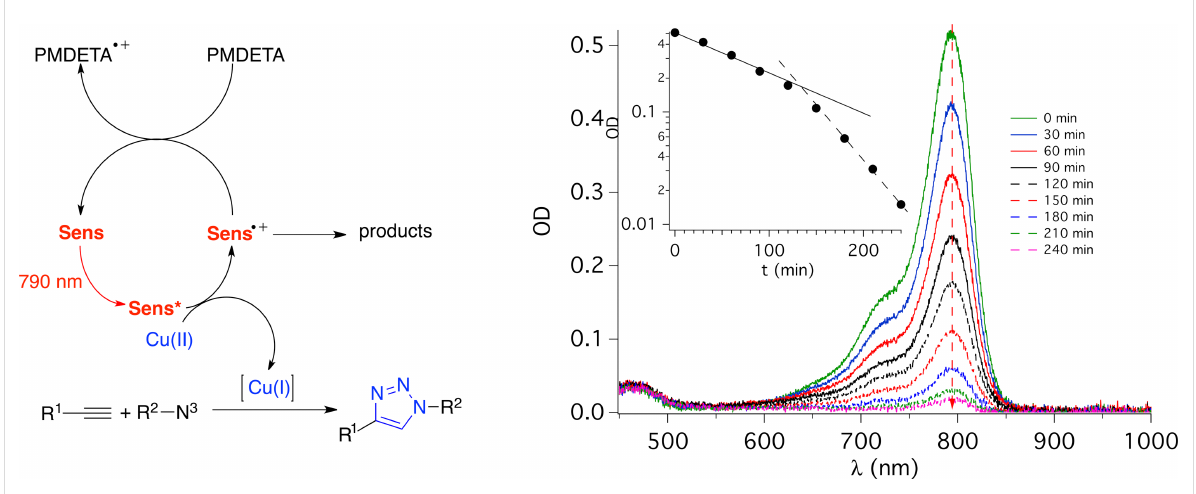
Figure 7: UV–vis–NIR absorption changes of the solution of 48 in the presence of PMDETA, phenylacetylene and benzyl azide in DMSO upon expo- sure at 790 nm (under nitrogen).